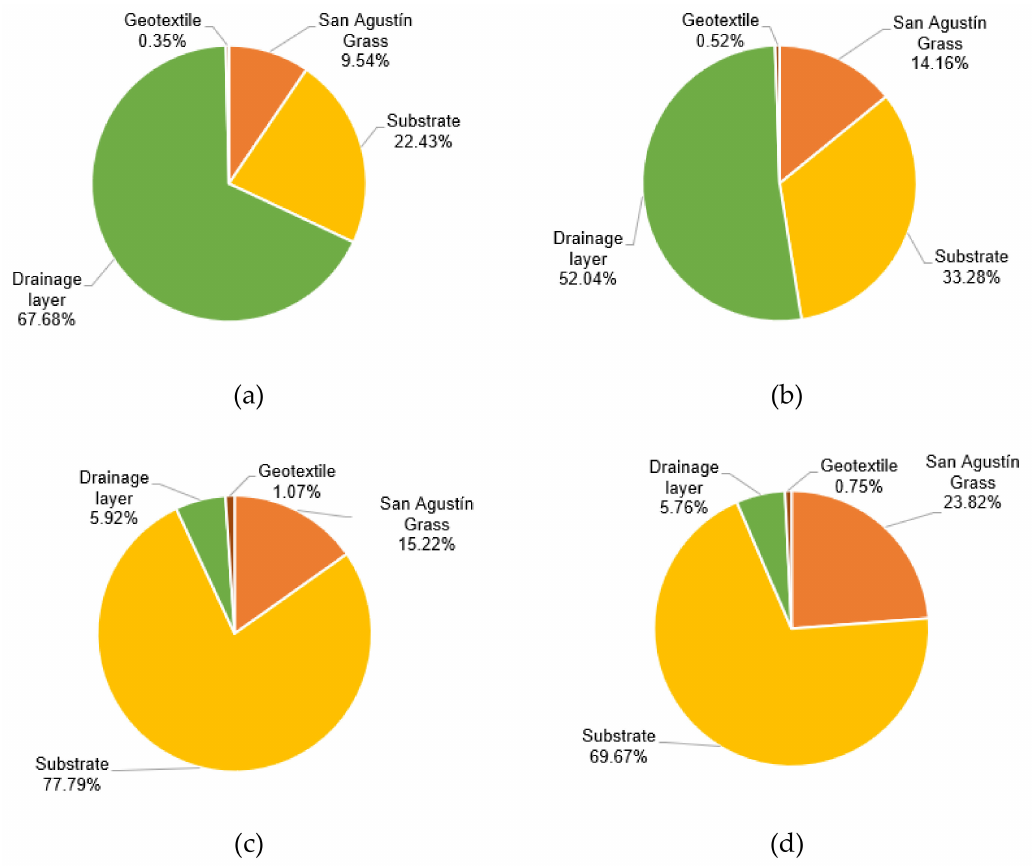
Figure 11. Weight distribution for each green roof prototype. ( a ) basalt gravel, ( b ) recycled rubber, ( c ) recycled PET bottles, and ( d ) recycled HDPE